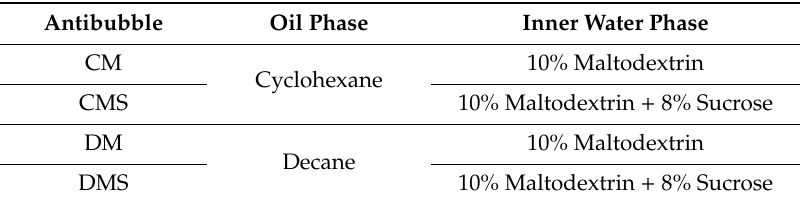
Table 1. Compositions that allowed for the successful production of antibubbles. C: cyclohexane; D: decane; M: maltodextrin; S: